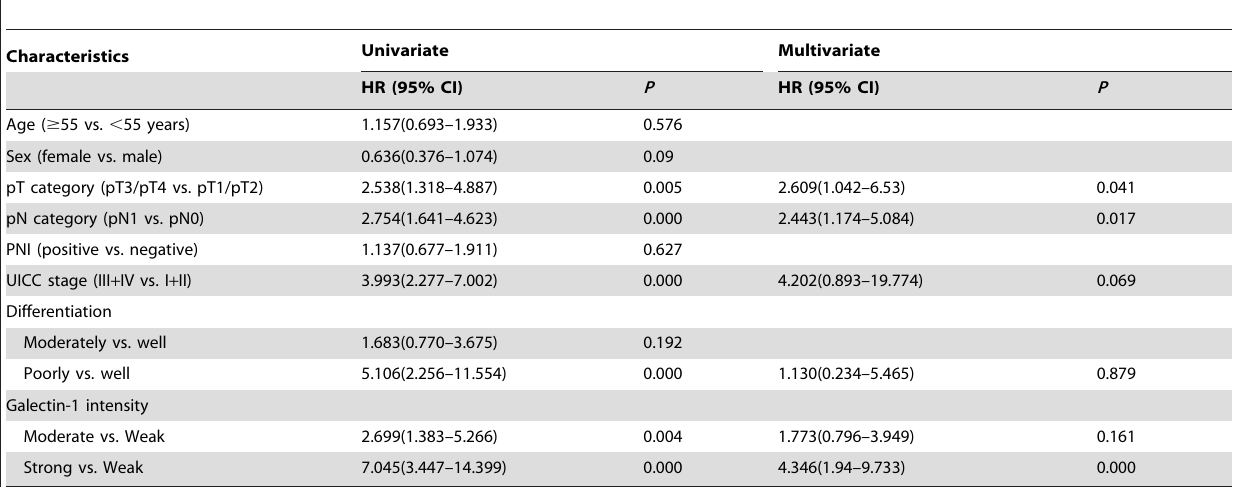
Table 2. Univariate and multivariate analysis of conventional prognostic factors and stromal galectin-1 expression in the patients with pancreatic